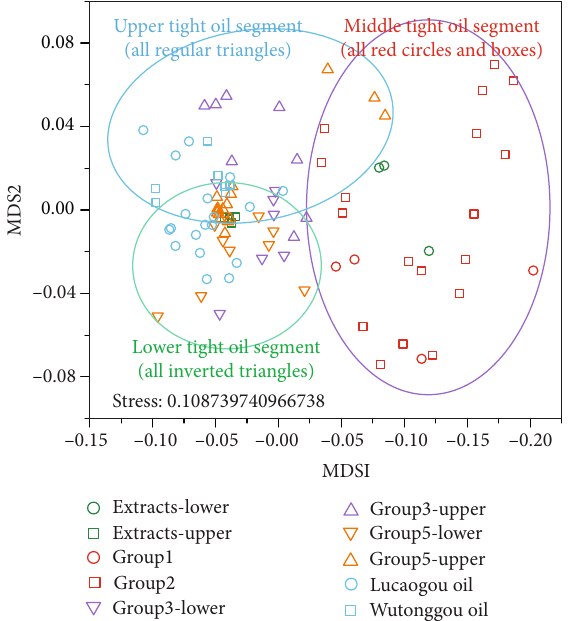
Figure 9: Results of multidimensional scaling (MDS) analysis, which separated the upper sweet spot region and intervening mudstone section into upper, middle, and lower tight oil segments. MDS1 and MDS2 de fi ne a 2-D space that allows the best spatial representation of sample similarities, without any inference of measured biomarker